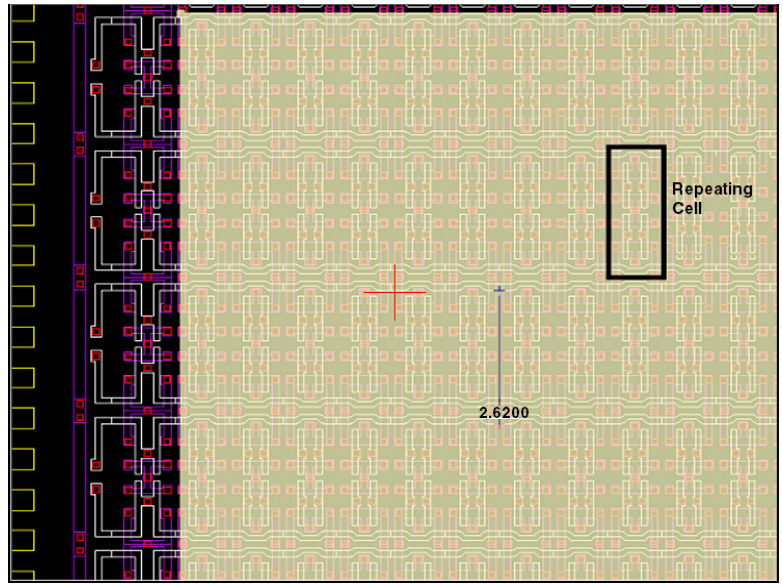
Figure 7. Overlay of die layout rectangle over layout polygons of repeating structures. The repetitive structures are marked separately as pattern of interest and specific inspection parameters are applied during inspection.